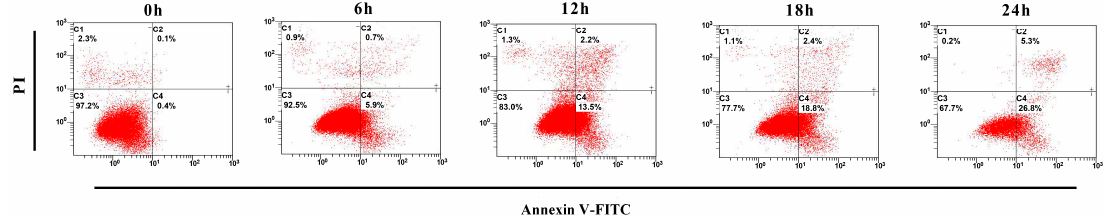
Figure 6. Flow cytometry detected apoptotic rate of Sf9 cells with Annexin V-FITC/PI double staining. The cells were treated with 7.5 μ g/mL ZC-14 for 0, 6, 12, 18 and 24 h, respectively.